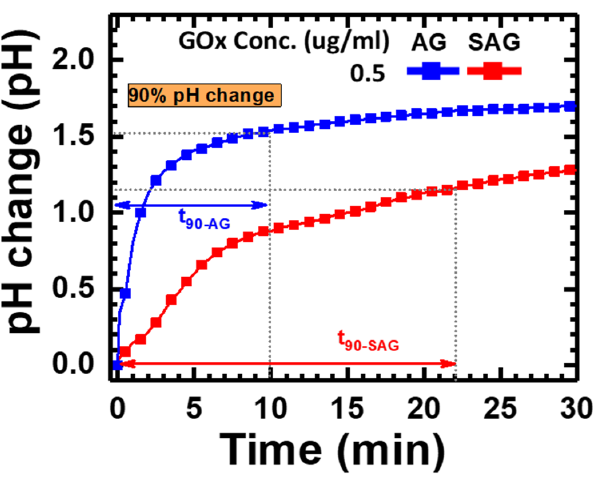
Figure 3. Time-dependent pH changes generated by avidin-conjugated or streptavidin-conjugated GOx at a concentration of 0.5 μg/mL in part #2 of the experiment. GOx at a concentration of 0.5 µ g/mL in part #2 of the